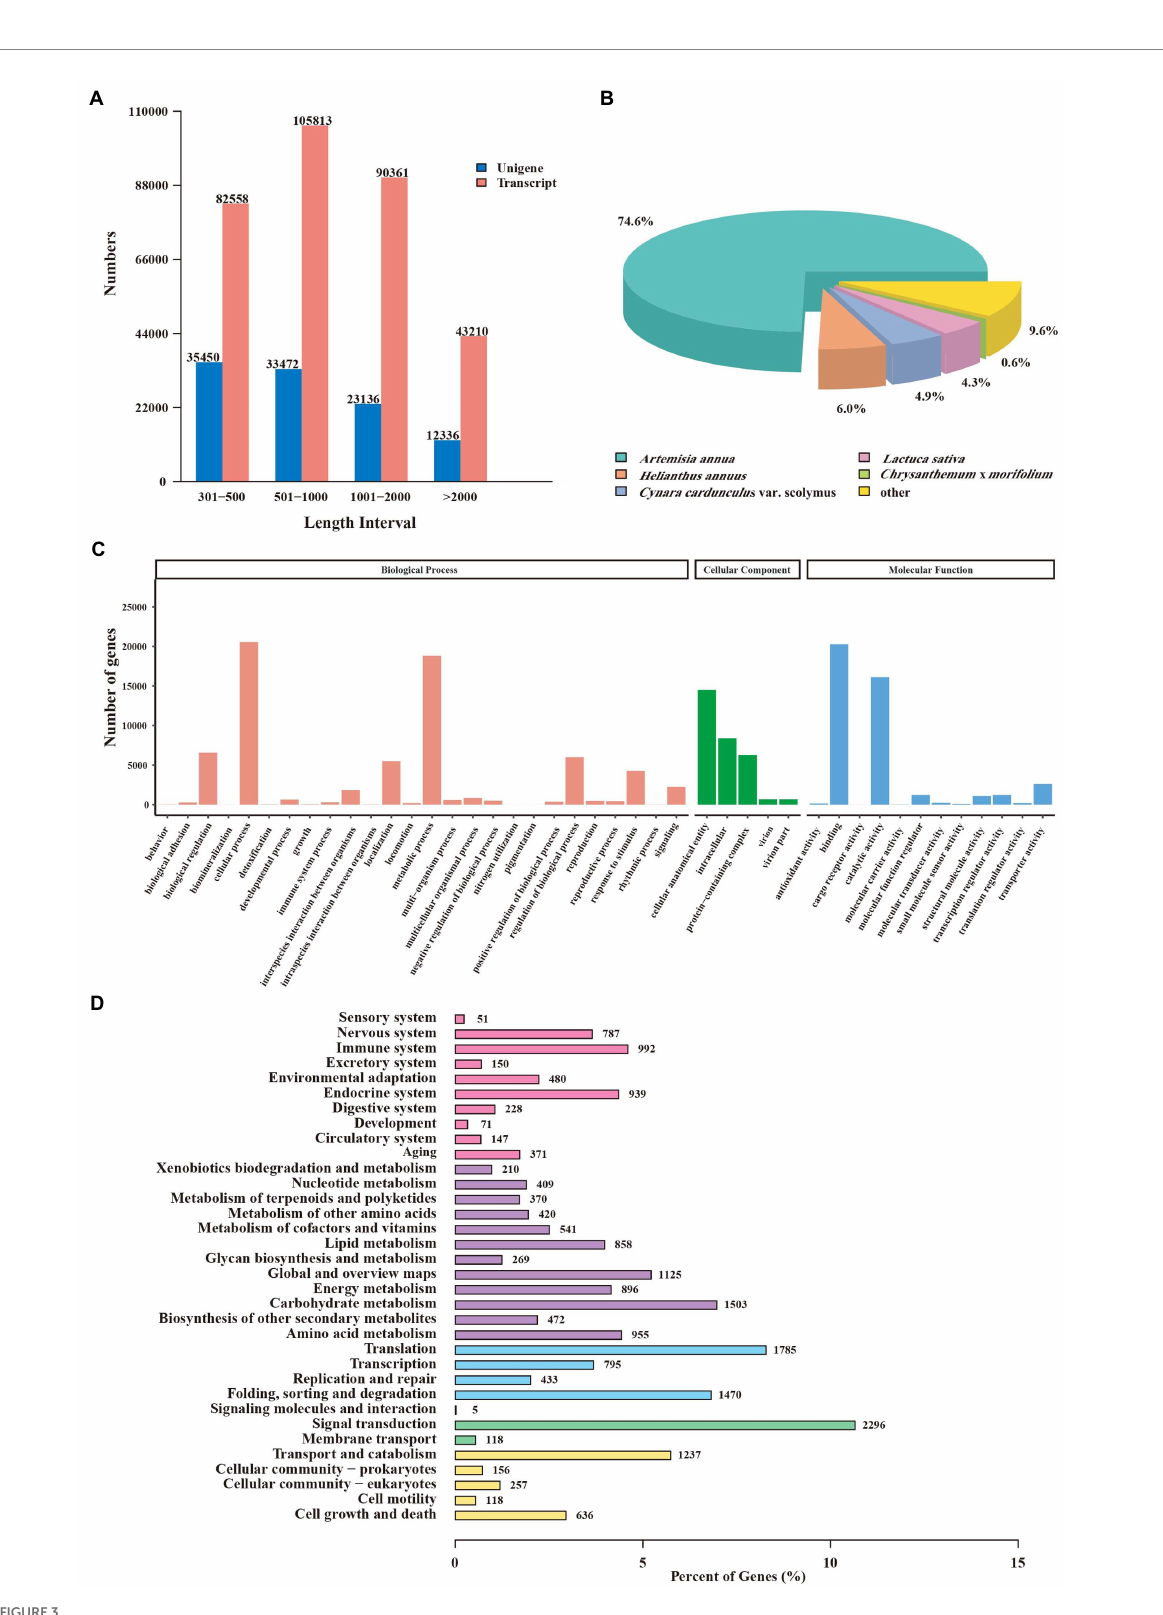
FIGURE 3 Annotation and functional analysis of unigenes from Chrysanthemum indicum var. aromaticum flowers. (A) The length distribution of transcripts and unigenes. (B) Species annotations of unigene homologs. (C) Gene ontology terms of unigenes. (D) Unigenes annotated in the KEGG